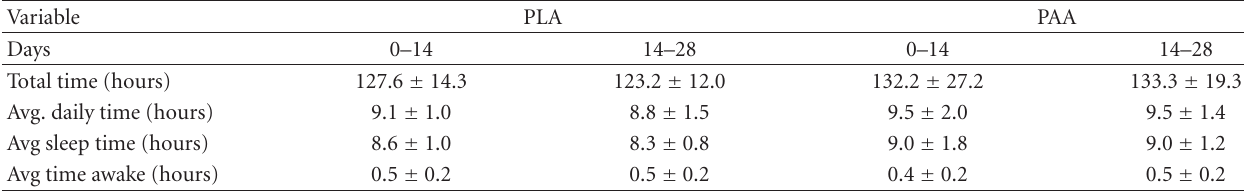
Table 3: Average time spent out of the ankle immobilization boot for placebo (PLA) and protein/amino acid (PAA) groups. All data are presented as mean ± standard deviation. Results indicated no significant di ff erences throughout the course of the study ( P > 0 . 05). Variable PLA